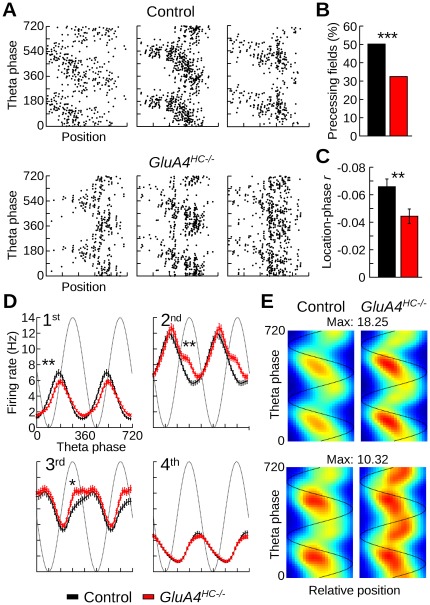
Theta phase precession in control and GluA4HC−/− mice. (A) Theta firing phase versus distance traveled through the field for three place fields recorded in control and GluA4HC−/− mice in the zigzag maze. (B) Percentage of firing fields for which there was a negative correlation (p<0.05) between the theta phase of the spikes and position within the field. (C) Mean r value (± SEM) between theta phase and position for firing fields in control and GluA4HC−/− mice. (D) Mean firing rate of pyramidal cells at different theta phases in 4 segments of the firing fields. The first and last segments correspond to the beginning and end of the firing field, respectively. (E) Mean spatio-temporal map of the firing fields in control and GluA4HC−/− mice. The x-axis is the relative position of the mouse within the firing field. Top row: spatio-temporal map for fields with significant theta phase precession. Bottom row: spatio-temporal map for fields without significant theta phase precession. *: p<0.05, **: p<0.01, *** p<10−
5.